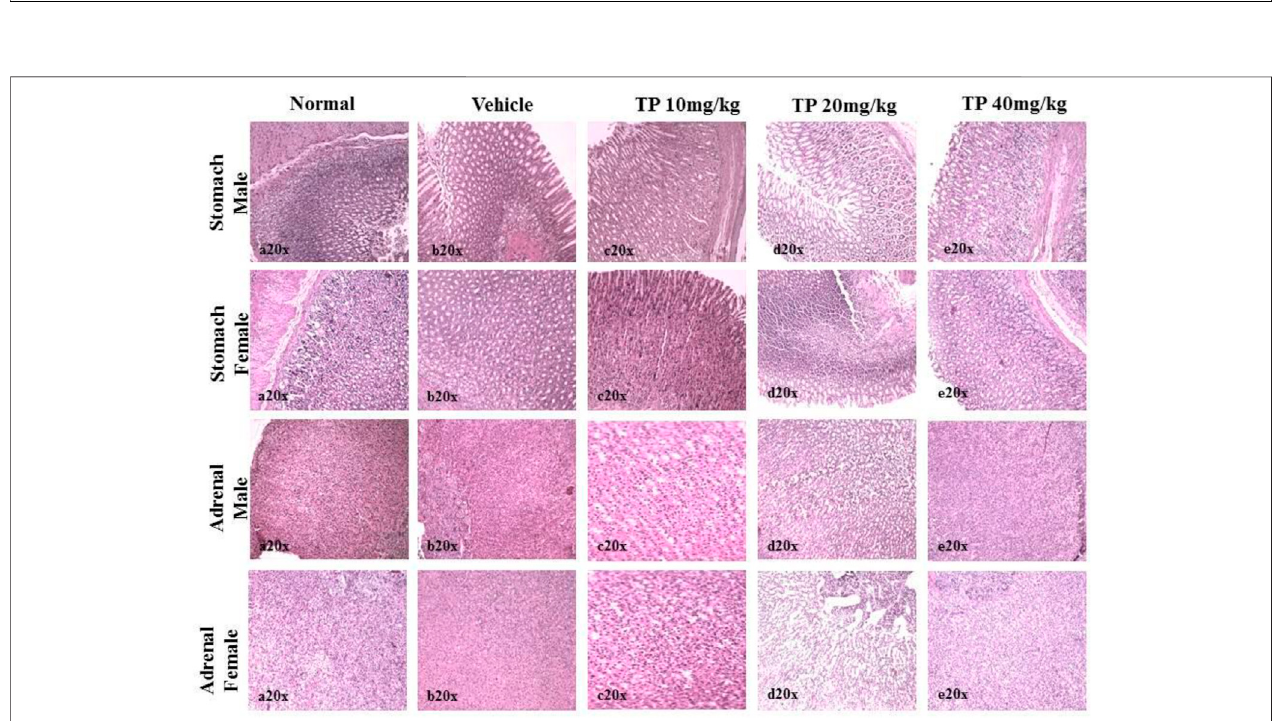
FIGURE14| Histopathologicalanalysisofstomachandadrenalsshowingnoulcerationandabnormalities,respectively,inthemaleandfemaleSDratsafter28-day treatment of Thamira parpam.